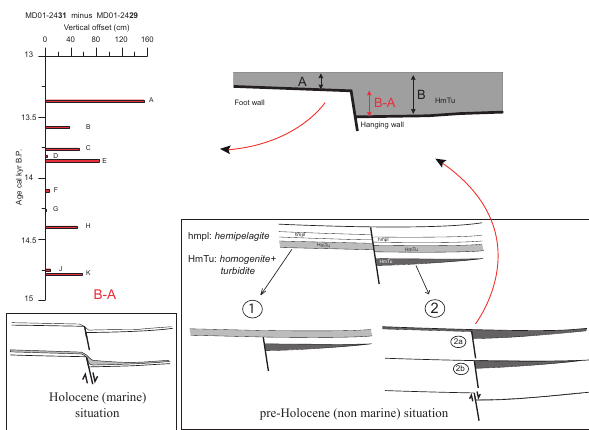
Figure 6. Successive inferred individual coseismic offsets deduced from HmTu thickness differences (insert sketch modified from Beck et al.,